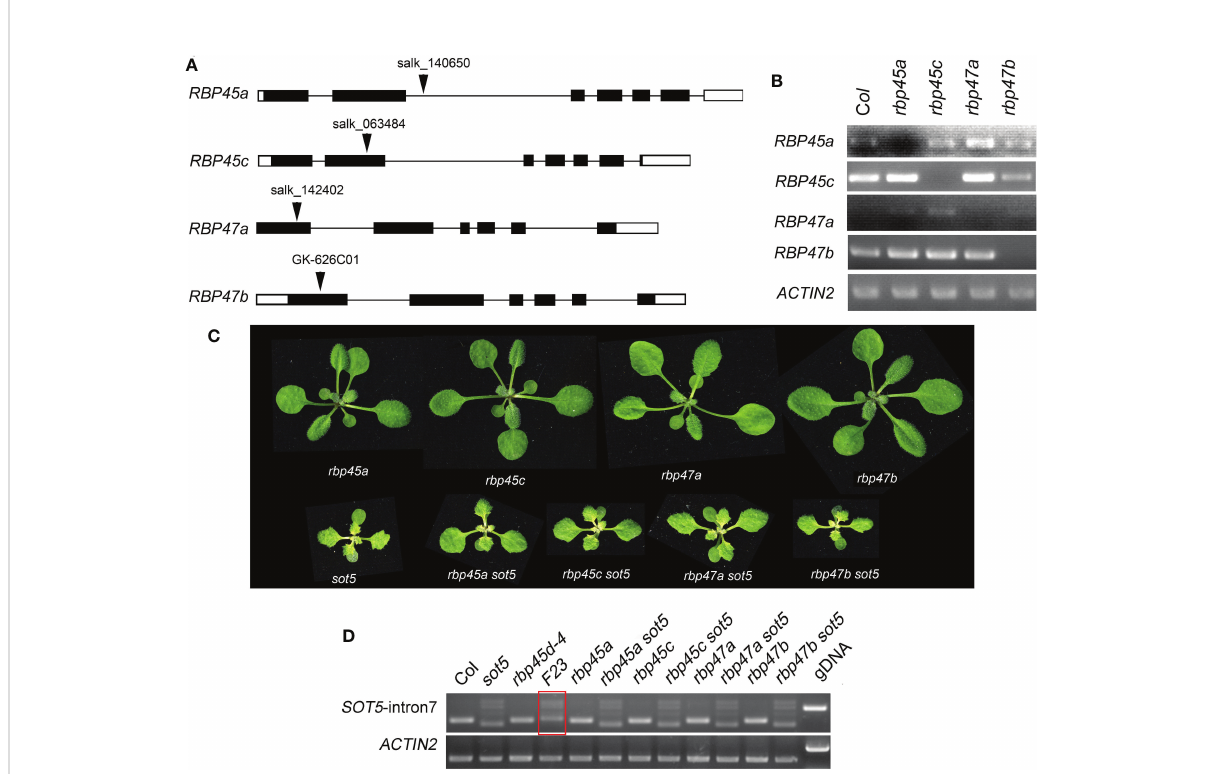
FIGURE 3 Mutations in other RBP45/47 paralogs cannot suppress the viresent phenotype of sot5. (A) Identi fi cation of T-DNA insertions in RBP45a, RBP45c, RBP47a and RBP47b genes. The black boxes indicate exons in UTR and the black rectangles indicate exons in CDS and the black lines indicate introns. Arrowheads indicate the insertional position of T-DNA for each gene. (B) RT-PCR analysis of gene expression in the T-DNA knockout mutants. ACTIN2 was used as an internal control. Two biological replicates (independent pools of aerial parts of plants) were analyzed, and one representative result is shown. (C) Phenotypes of single and double mutants as indicated. (D) Semi-quantitative RT-PCR showed the splicing pattern of SOT5 intron 7 in sot5 RBP45a, sot5 RBP45c, sot5 RBP47a and sot5 RBP47b double mutant when compared with that in F23 ( sot5 rbp45d-4 ). The red box highlighted the altered splicing pattern of SOT5 intron 7 in F23.